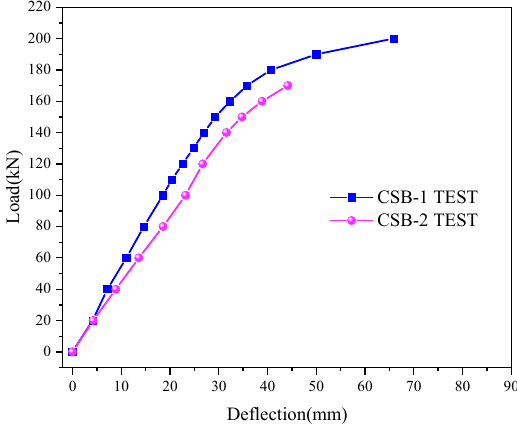
Figure 7. Load–deflection curves.